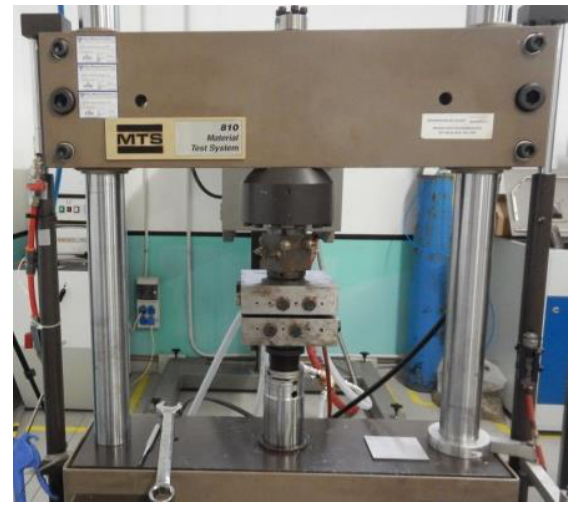
Figure 4. The die demonstrator placed on the hydraulic press.